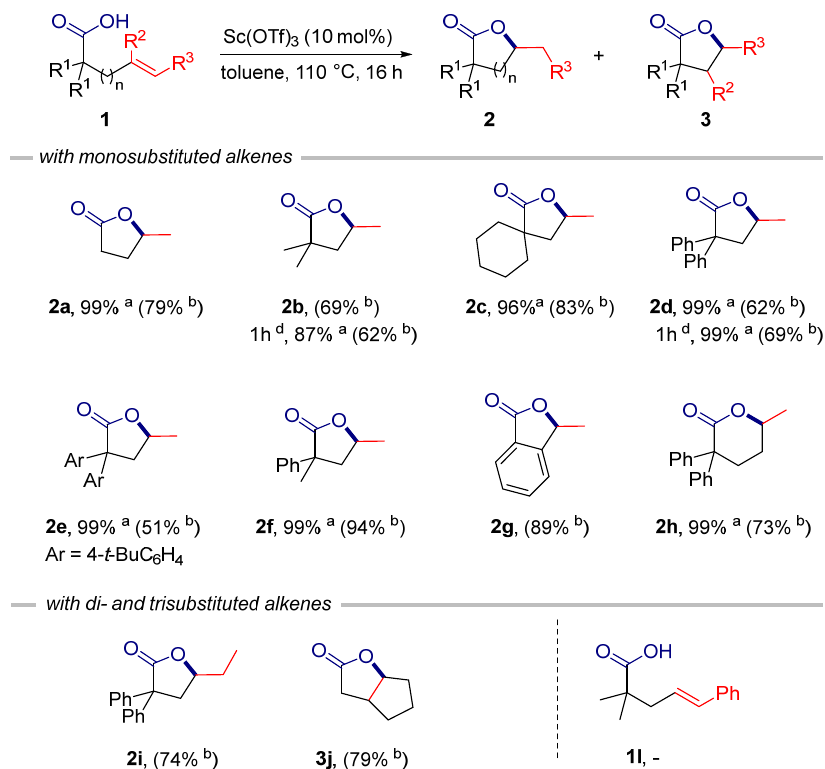
Figure 3. Formation of γ -and δ -lactones by Sc(OTf) 3 -catalyzed cyclization of alkenoic acids featuring mono-, di- and trisubstituted olefins. c a yields were determined by 1 H NMR using 1,3,5-trimethox- ybenzene as the internal standard; b isolated yields; c all reactions run under thermal conditions unless otherwise stated; d run under microwave conditions.